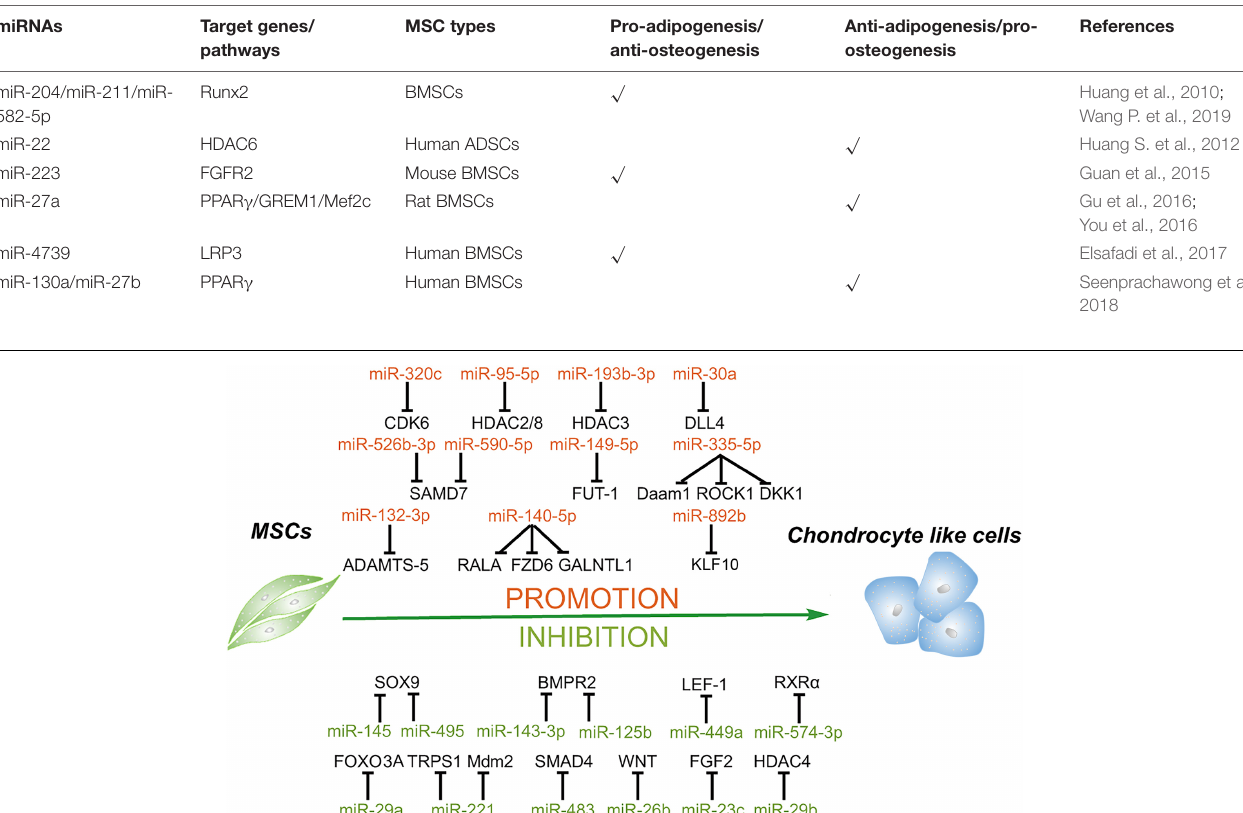
TABLE 3 | MicroRNAs involved in modulating the balance of adipogenesis and osteogenesis of MSCs. miRNAs